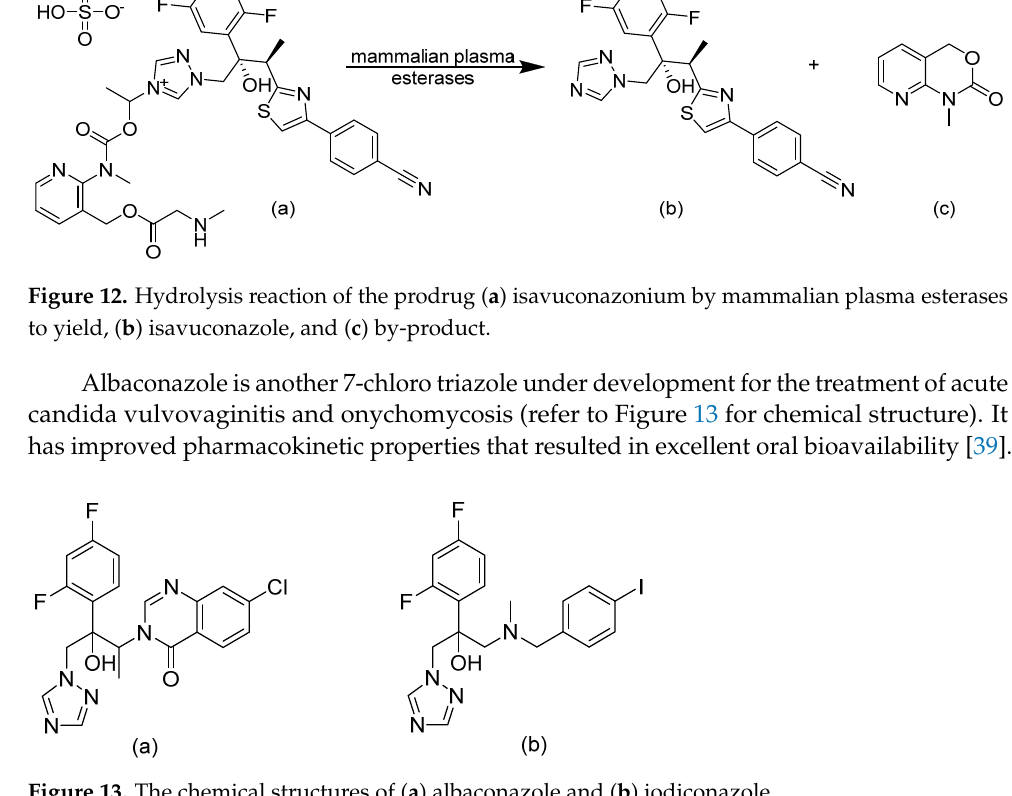
Figure 13. The chemical structures of ( a ) albaconazole and ( b ) iodiconazole.